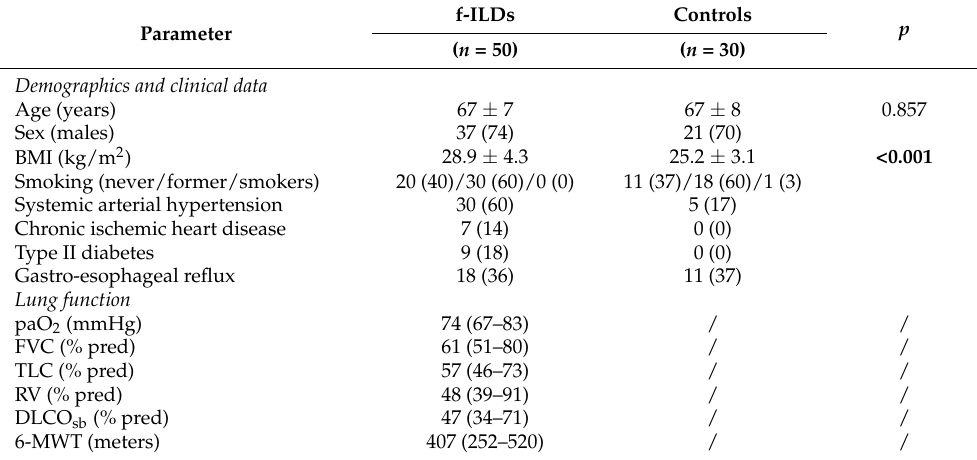
Table 1. Demographics, clinical characteristics, and lung function of the study population.